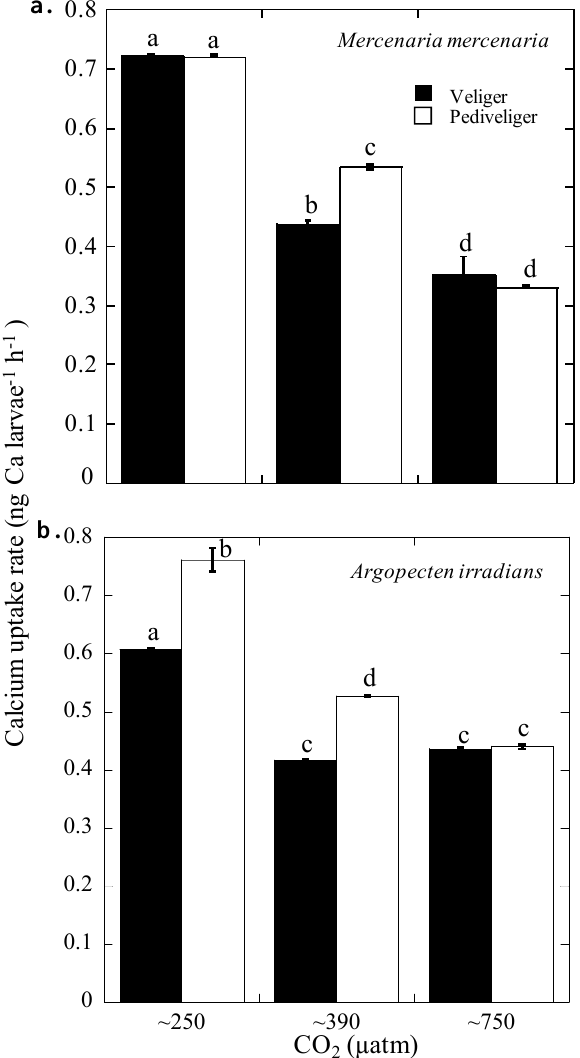
Fig. 1. Mean calcium uptake ± 1 standard deviation for larvae from Figure 1. Mean calcium uptake ± 1 standard deviation for larvae from two 941 two developmental stages of Mercenaria mercenaria (veligers from developmental stages of Mercenaria mercenaria (veligers from day 3, and pediveligers 942 day 3, and pediveligers from day 10) and Argopecten irradians lar- from day 10 ) and Argopecten irradians larvae (veligers from day 12, and pediveligers 943 vae (veligers from day 12, and pediveligers from day 15). Larvae from day 15 ). Larvae were grown under pCO were grown under p CO 2 of approximately 250, 390, and 750µatm (Table 1). Letters indicate significant differences revealed from Tukey post-hoc 945 CO CO 2 (Table 1). Letters indicate significant differences revealed from 2 multiple comparisons, p ≤ 0.05 for all. 946 Tukey post hoc multiple comparisons, p ≤ 0 . 05 for